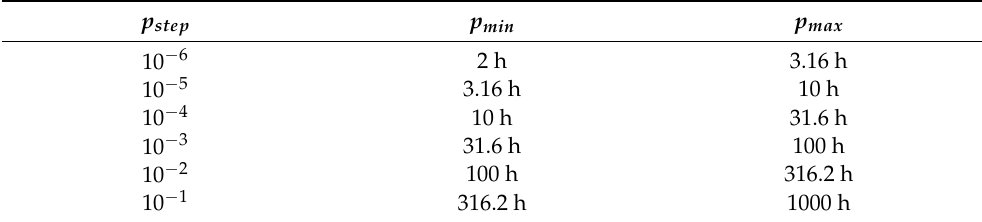
Table 7. The maximum and minimum periods corresponding to the period step size of different orders of magnitude after converting the frequencies ( f step = 10 − 6 h − 1 , ranging from 0 to 0.5 h − 1 ) to